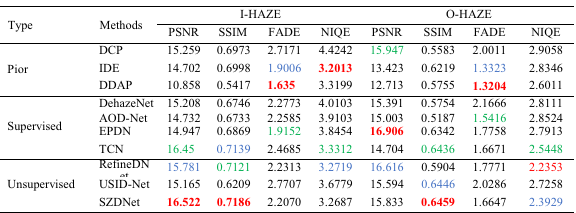
Table 2 Quantitative comparison between SZDnet and SOTA meth- ods on the I-haze and O-haze datasets. The best, second best, and third best performances are marked in red, blue, and green, respec-